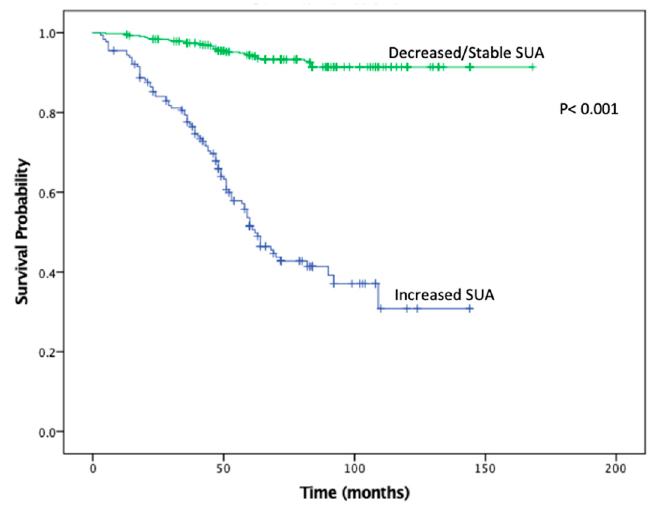
Figure 2. Kaplan-Meier plot for recurrence free survival in the stable / decreased uric acid and increased uric acid groups.